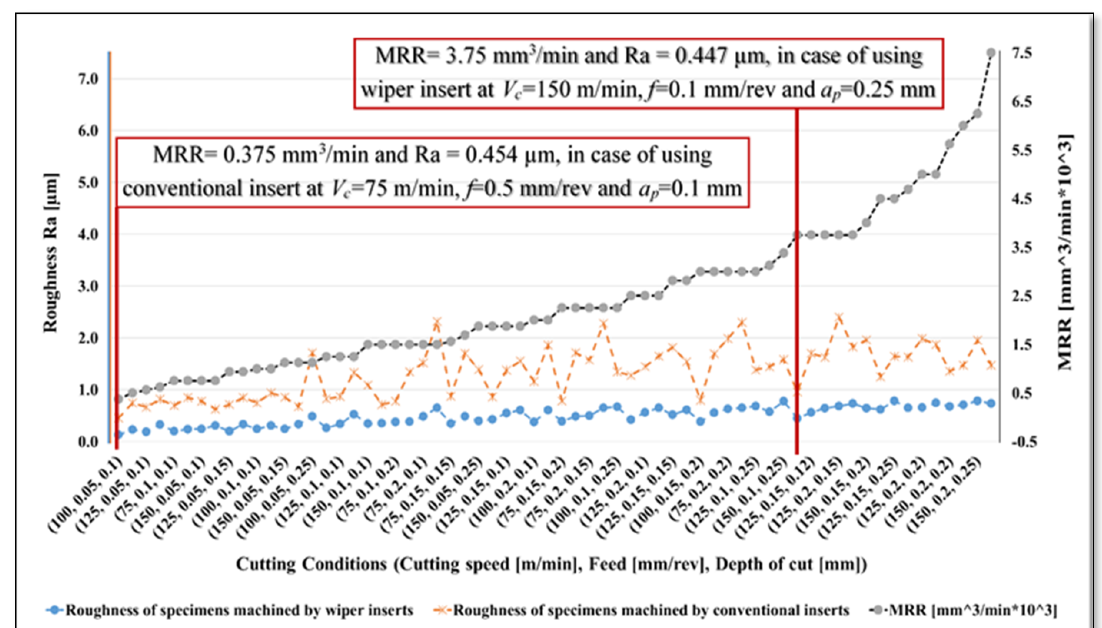
Figure 8. Material removal rate (MRR) and average resultant roughness (Ra µm) of AISI 4340 specimens machined by wiper and conventional